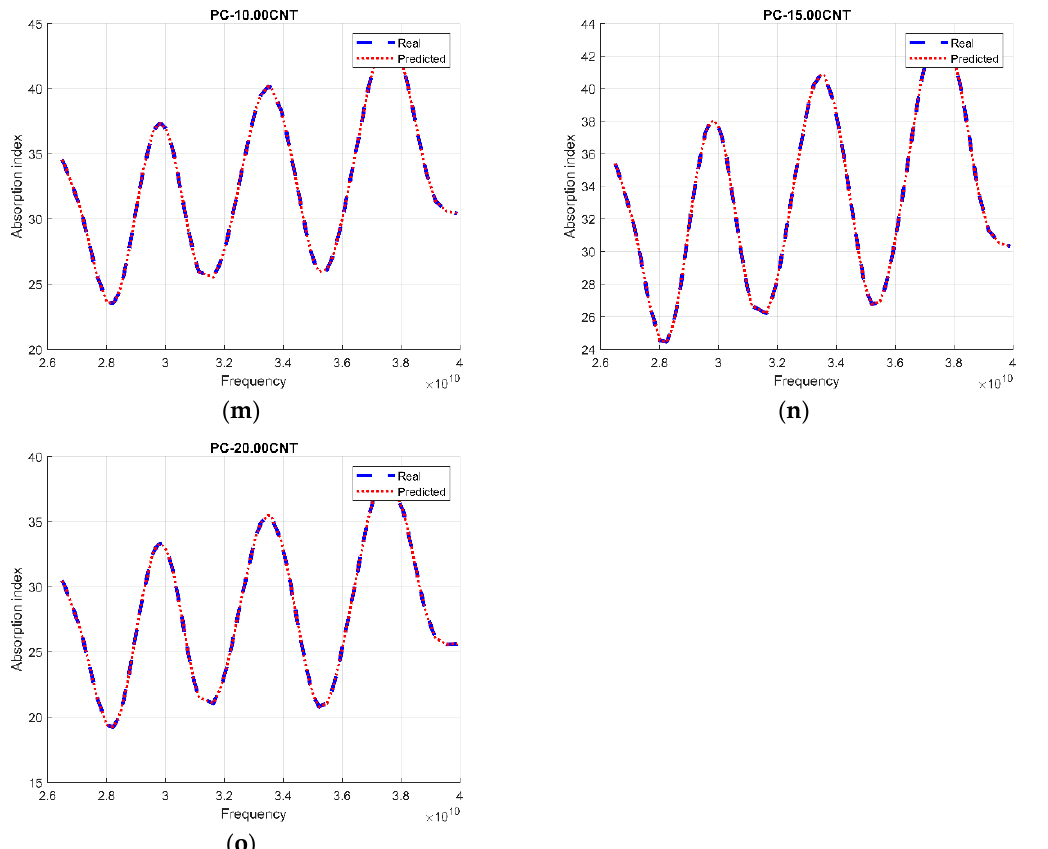
Figure 4. System evaluation on the test set, the blue and red lines, respectively, show the actual and predicted absorption of the measured sample MLP from the lowest CNT load ( a ) up to the highest load ( o ).